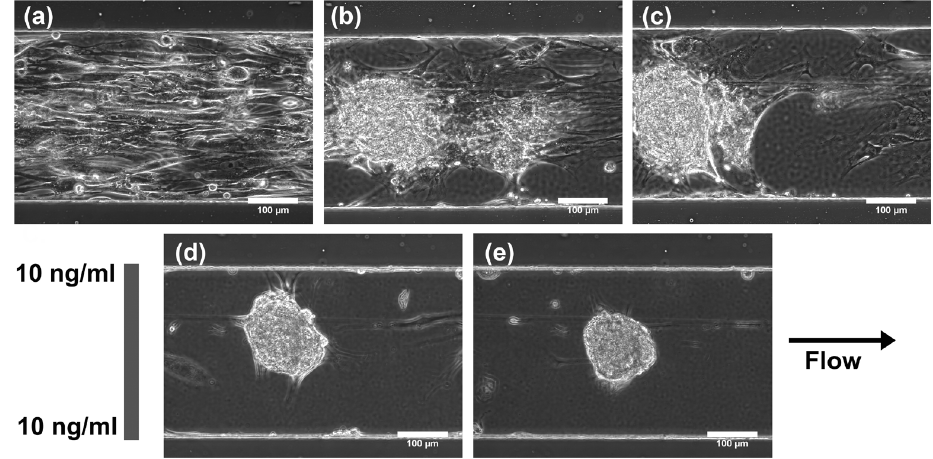
Figure 7. Effect of constant TGF- β1 concentration on MSC chondrogenesis. Phase contrast images of a region within the control device on ( a ) day 1(just prior to TGF- β1 exposure), ( b ) day 6, ( c ) day 8, ( d ) day 14, and ( e ) day